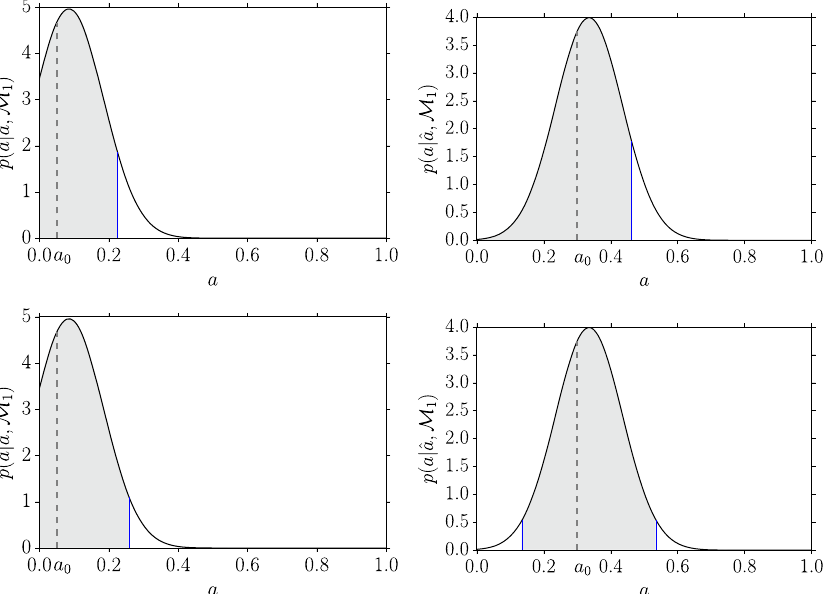
Fig. 15 Posterior distributions for the amplitude a given the value of the maximum-likelihood estimator ˆ a . The left two panels are for the weak injection; the right two panels are for the strong injection. The top two plots illustrate the graphical construction of Bayesian 90% upper limits for the two injections; the bottom two plots illustrate the graphical construction of the Bayesian 95% credible intervals. The dashed vertical lines indicate the values of the injected signal amplitude a 0 , which equal 0.05 and 0.3, respectively